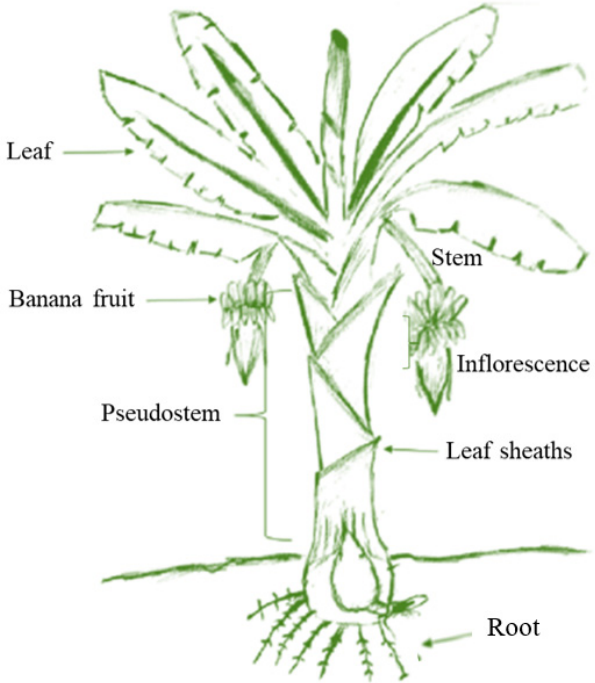
Figure 2. The structure of banana plant. Adapted from [11].